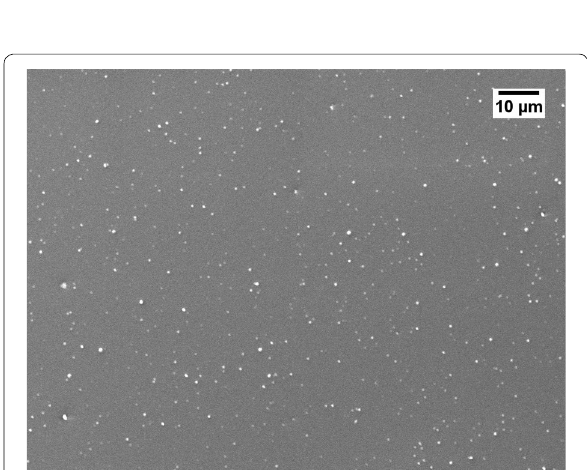
Fig. 3 SEM image of PEI membrane made by GBL and 23 wt% PEI